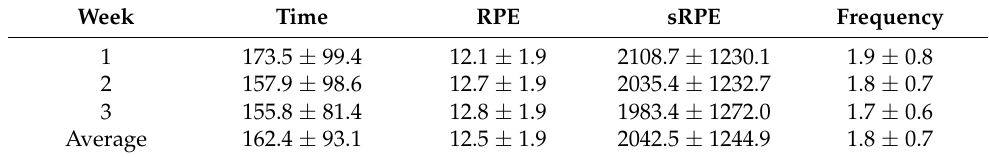
Table 2. Mean and standard deviation of the time (minutes), rate of perceived exertion (RPE), session RPE (sRPE), and frequency (times per week) for the La Crosse Exercise and Health Program.